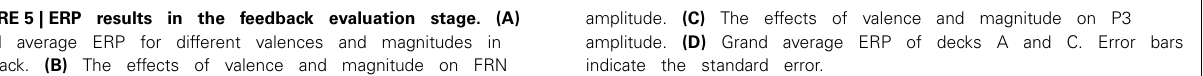
amplitude. (C) The effects of valence and magnitude on P3 amplitude. (D) Grand average ERP of decks A and C. Error bars indicate the standard